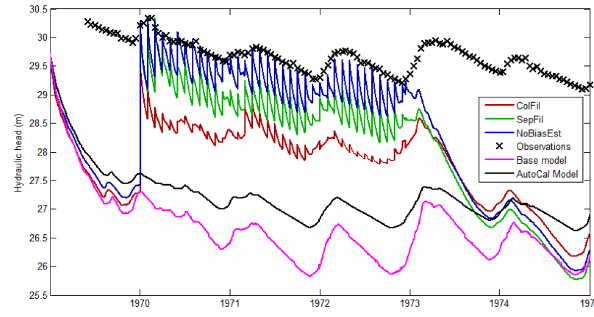
Figure 8. Nash–Sutcliffe coefficient for stream discharge (left panel) and mean RMSE of groundwater head observations (right panel) in the assimilation and validation periods, respectively (real data).